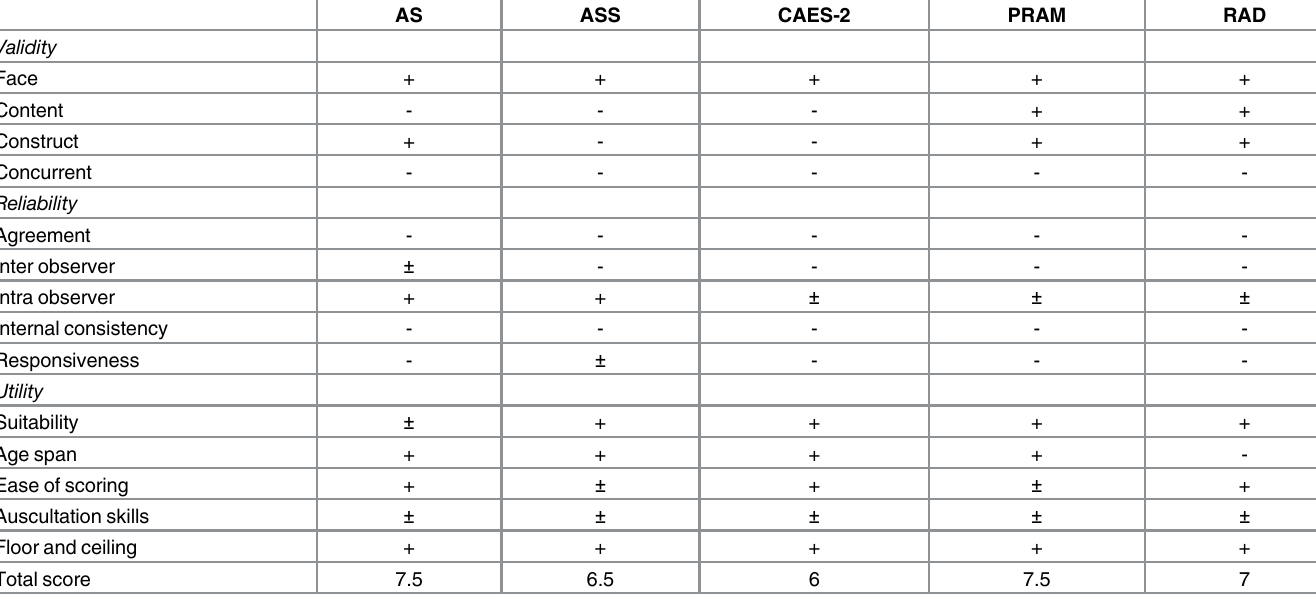
Table 7. Summary of assessed quality criteria for the five dyspnoea scores bases on this study and earlier review by Bekhof et